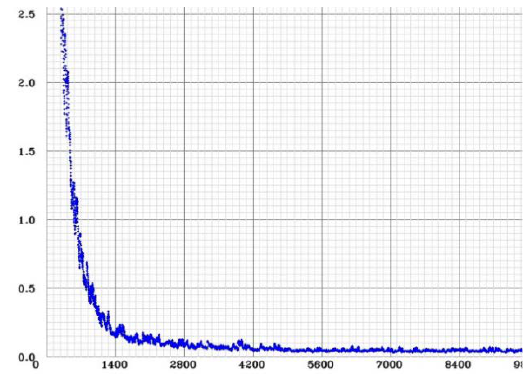
Figure 3. The average loss with respect to iteration rounds during the training phase.